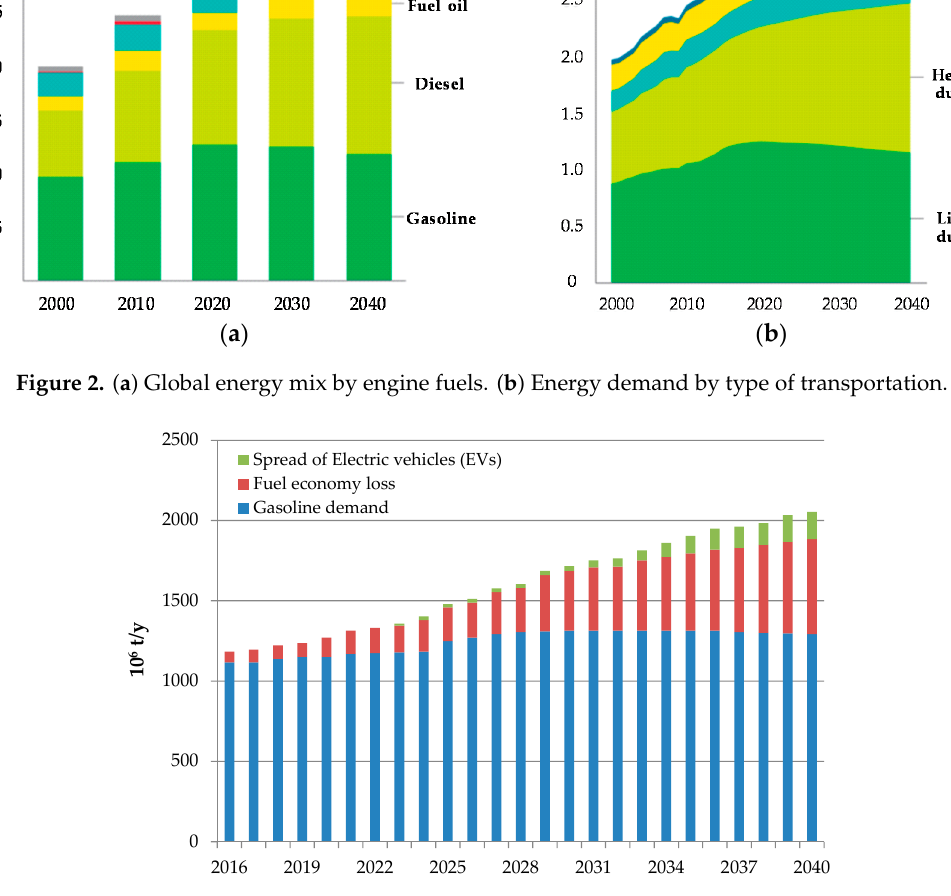
Figure 3. Expected gasoline demand taking into account to better fuel economy and the spread of electric vehicles.